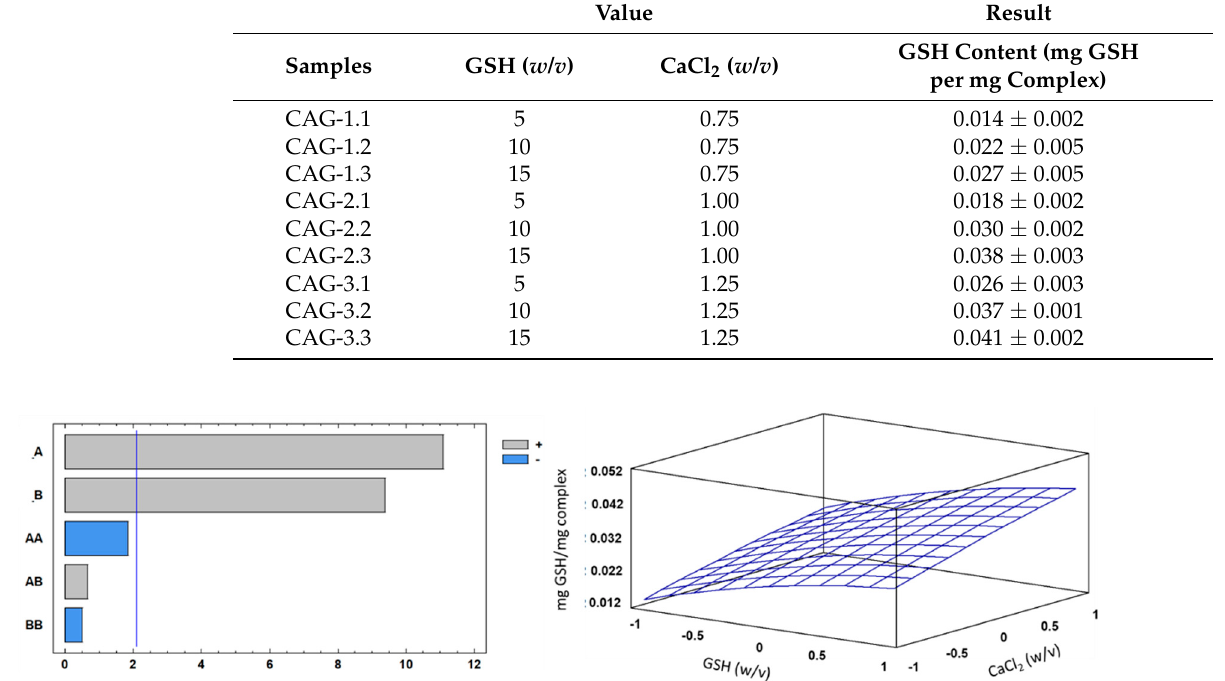
Figure 8. Standardized Pareto chart for mg GSH/mg complex, where A corresponds to the percentage of GSH ( w / v ); B, CaCl 2 concentration ( w / v ); and AB, their interaction. The blue line in figure a represents the critical t -value, 95% confidence, while figure b corresponds to the estimated response surface for mg GSH/mg complex.